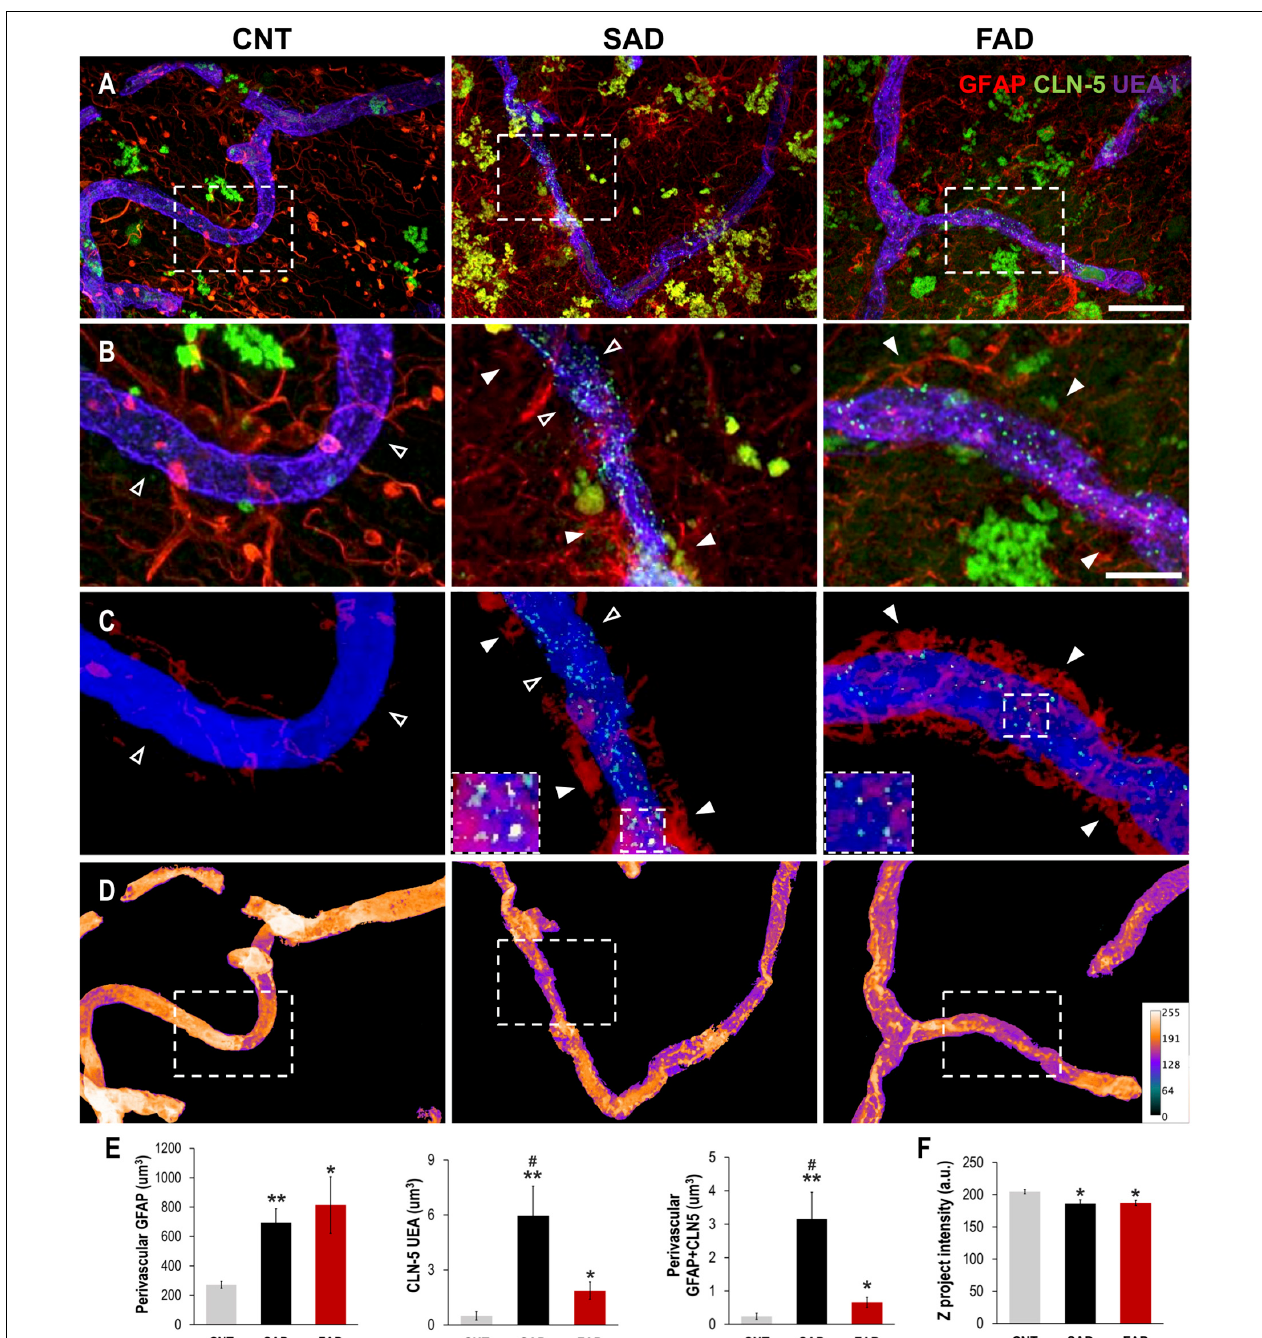
FIGURE 8 | Perivascular GFAP processes are related to altered CLN-5 expression and structural deterioration of the brain vessels in human AD. (A) Representative images of triple immunolabeling of GFAP, CLN-5 and the endothelial marker UEA I showing increased astrocytic reactivity near the vessels, and augmented CLN-5 expression in SAD and FAD. (B) 2X magnifications of the insets in panel (A) highlighting the augment of both perivascular GFAP processes and vascular CLN-5 in AD. (C) Segmented images of GFAP processes present between 0 and 2 µ m away from the vessel surface showing the proximity of CLN-5 with vascular areas covered by GFAP. White arrowheads indicate regions where high GFAP vascular coverage coincides with high CLN-5 staining, while empty arrowheads point to areas where both GFAP and CLN-5 are scarce. The insets are 2X magnifications of double positive GFAP-CLN-5 areas. (D) Heat map representation of superposed UEA I signals indicating structural alteration as intensity values go down. Note that the boxes in panel (D) that are enclosing vascular regions with low intensity values, correspond to the images shown in panel (C) which display increased GFAP and CLN-5. (E) Quantification of the perivascular volume of GFAP, vascular CLN-5, and perivascular double positive GFAP-CLN-5. ∗ Comparison with CNT, levels of significance were set to * p < 0.05 and ** p < 0.01. # Comparison SAD with FAD, levels of significance were set to # p < 0.05. (F) Quantification of the Z projected intensity of UEA I. ∗ Comparison with CNT, levels of significance were set to * p < 0.05. Scale bar: (A,D) , 20 µ m; (B,C) , 10 µ m. Data are presented as mean ± SEM from CNT n = 5, SAD n = 4, and FAD n = 7; independent